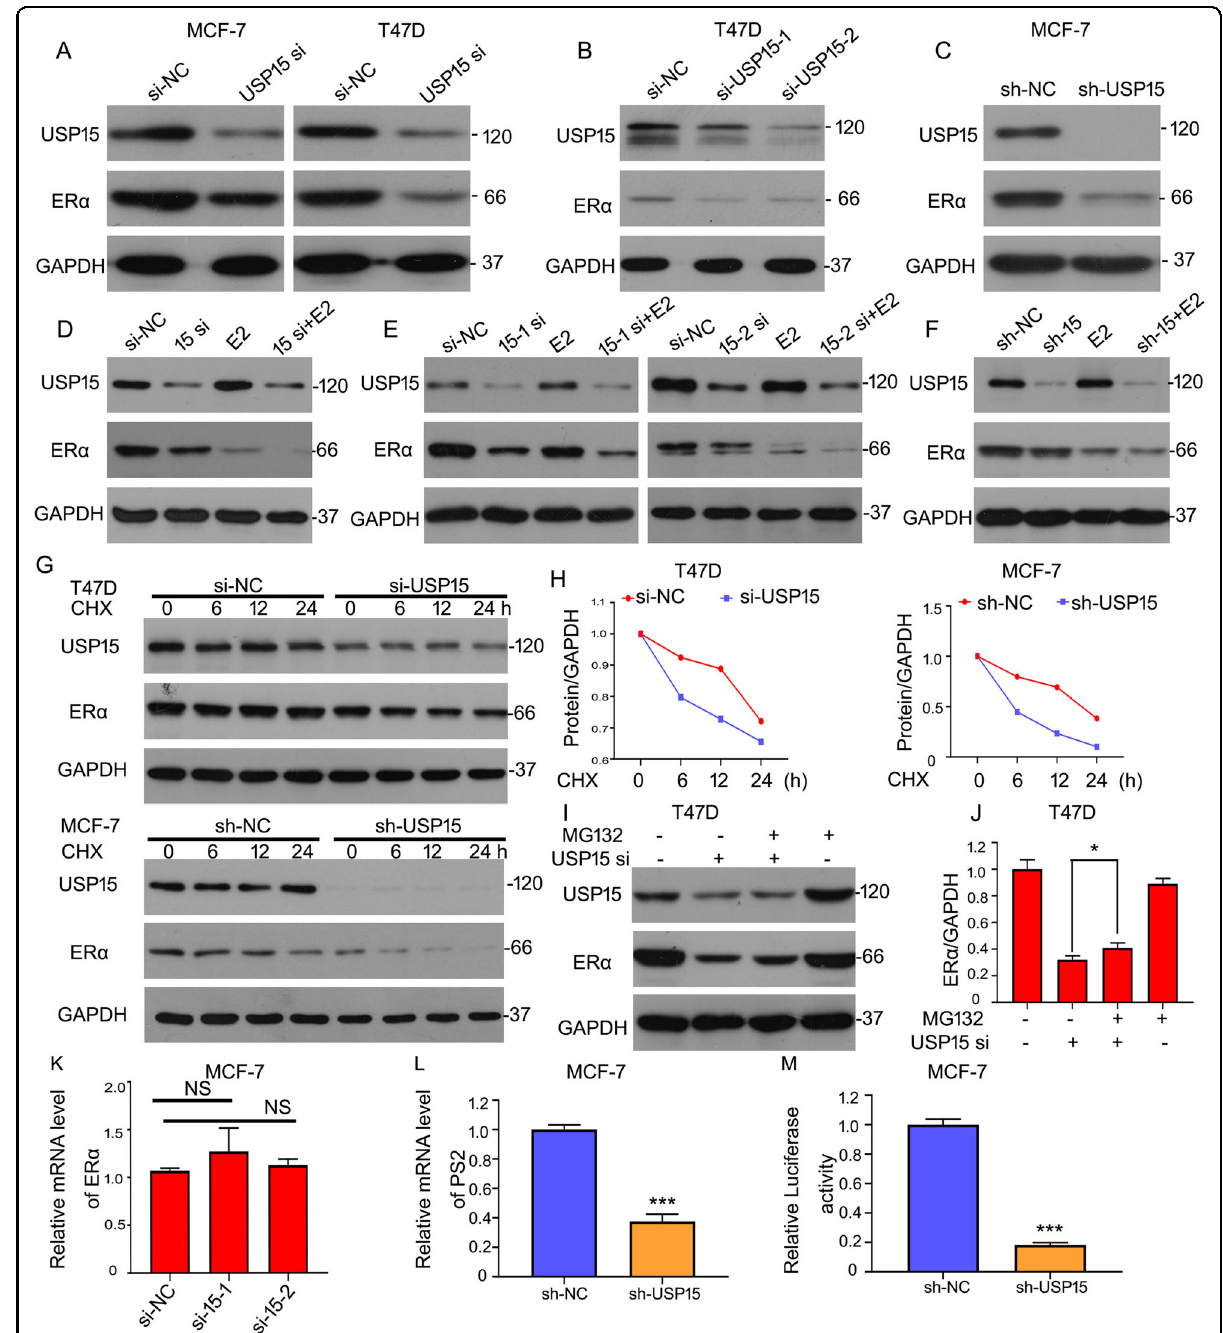
Fig. 3 USP15 stabilizes the expression of ER α in BC. A – C Cells were treated with USP15 siRNA targeting different sets or stably expressing shRNA. Western blot assay for USP15 and ER α expression. D – F Cells were treated with E2 for 12 h after transfection for 36 h. USP15 and ER α expression were tested. G Cells were treated with USP15 siRNA or shRNA and CHX (50 μ g/ml). USP15 and ER α expression were evaluated. H The value of ER α band was calculated. I , J USP15 siRNA and MG132 were used to treated with T47D cells, and ER α protein was analyzed by western blot. * p < 0.05. K Total RNA were extracted from MCF-7 cells treated with USP15 siRNA targeting different sets, subjected to RT-qPCR for mRNA level of ER α . L Total RNA was collected from MCF-7 cells stably expressing shRNA-USP15 and RT-qPCR was applied to evaluate the mRNA level of PS2. M Luciferase reporter plasmid containing estrogen receptor elements (EREs) transfected into MCF-7 cells which stably expressing shRNA-USP15 for 6 h. Then medium was replaced by 10% FBS DMEM. Protein lysates were collected, followed by dual-luciferase assay. *** p <